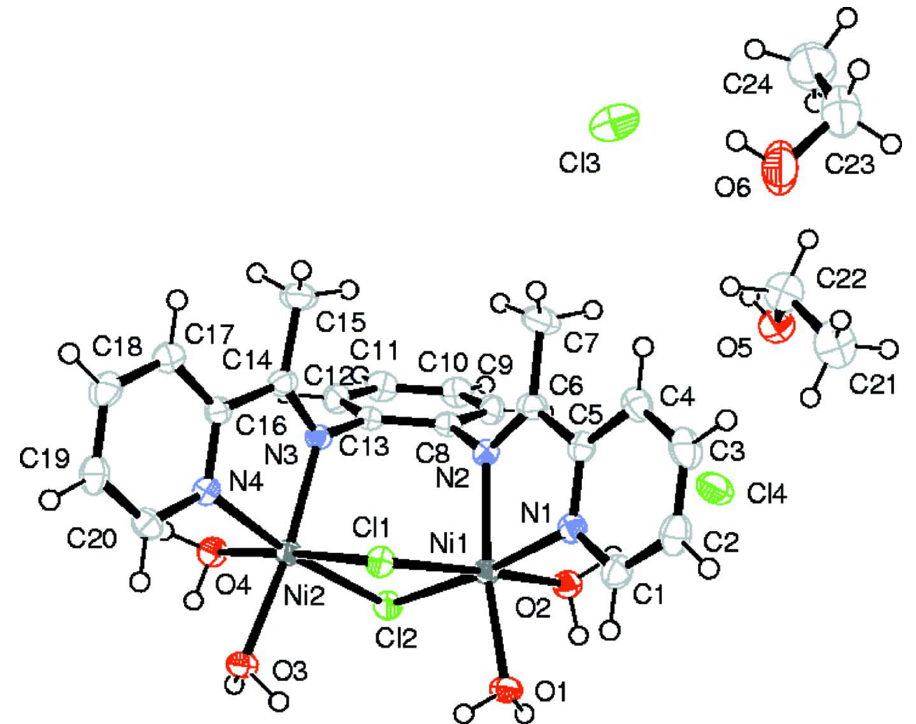
Figure 1 The molecular structure of (I) with displacement ellipsoids for the nno-hydrogen atoms plotted at the 50% probability level.